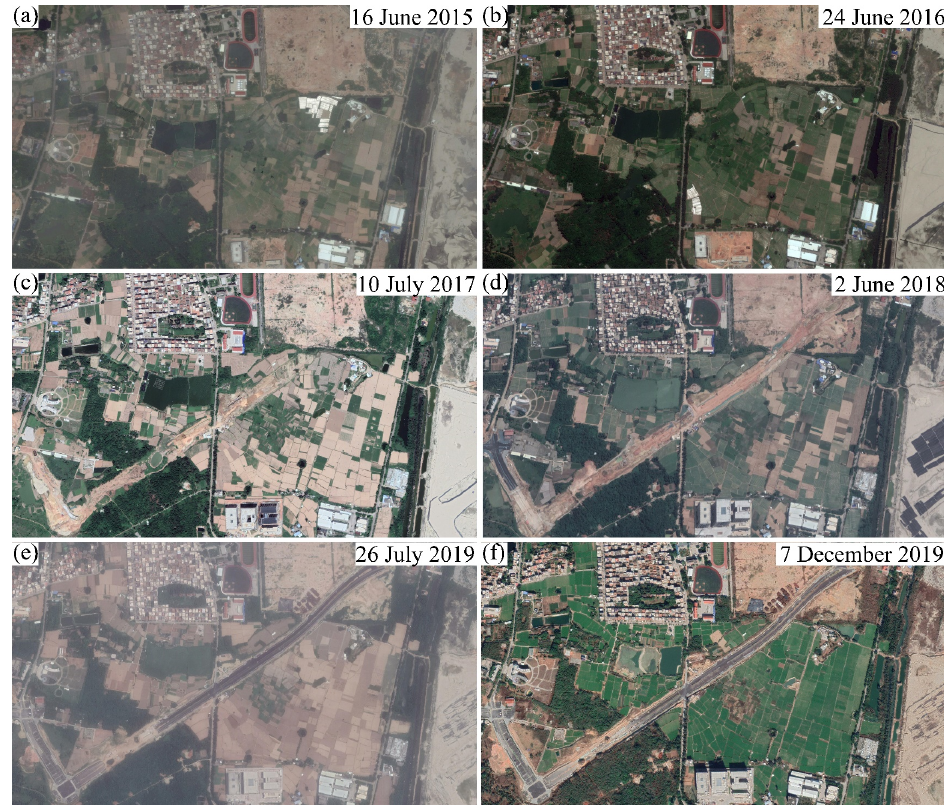
Figure A2. Locations of points P7–P12.